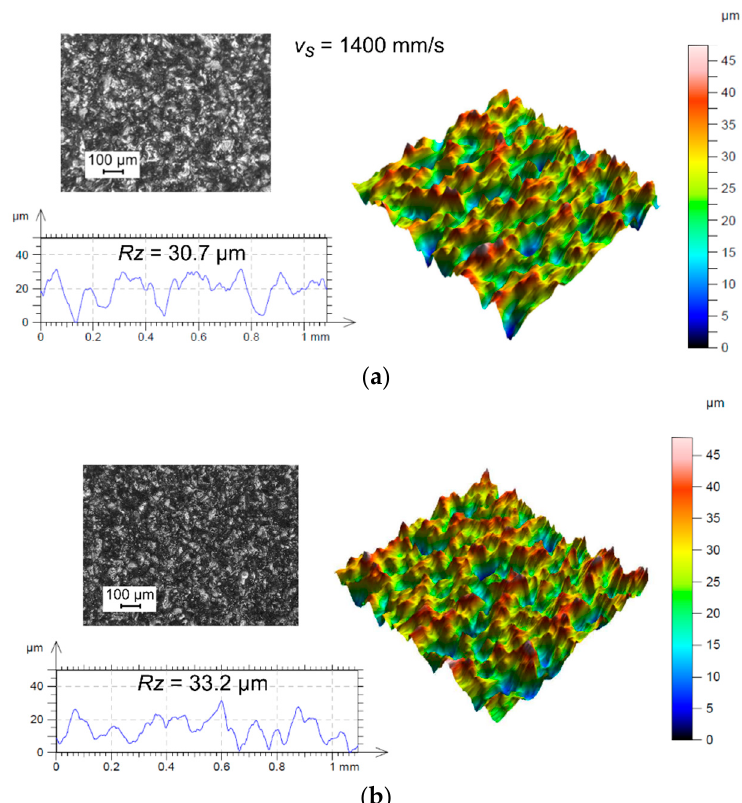
Figure 10. The surface texture in the case of the applied current amplitude if I = 32 A for: the sintered sample ( a ) and the cast sample ( b ).